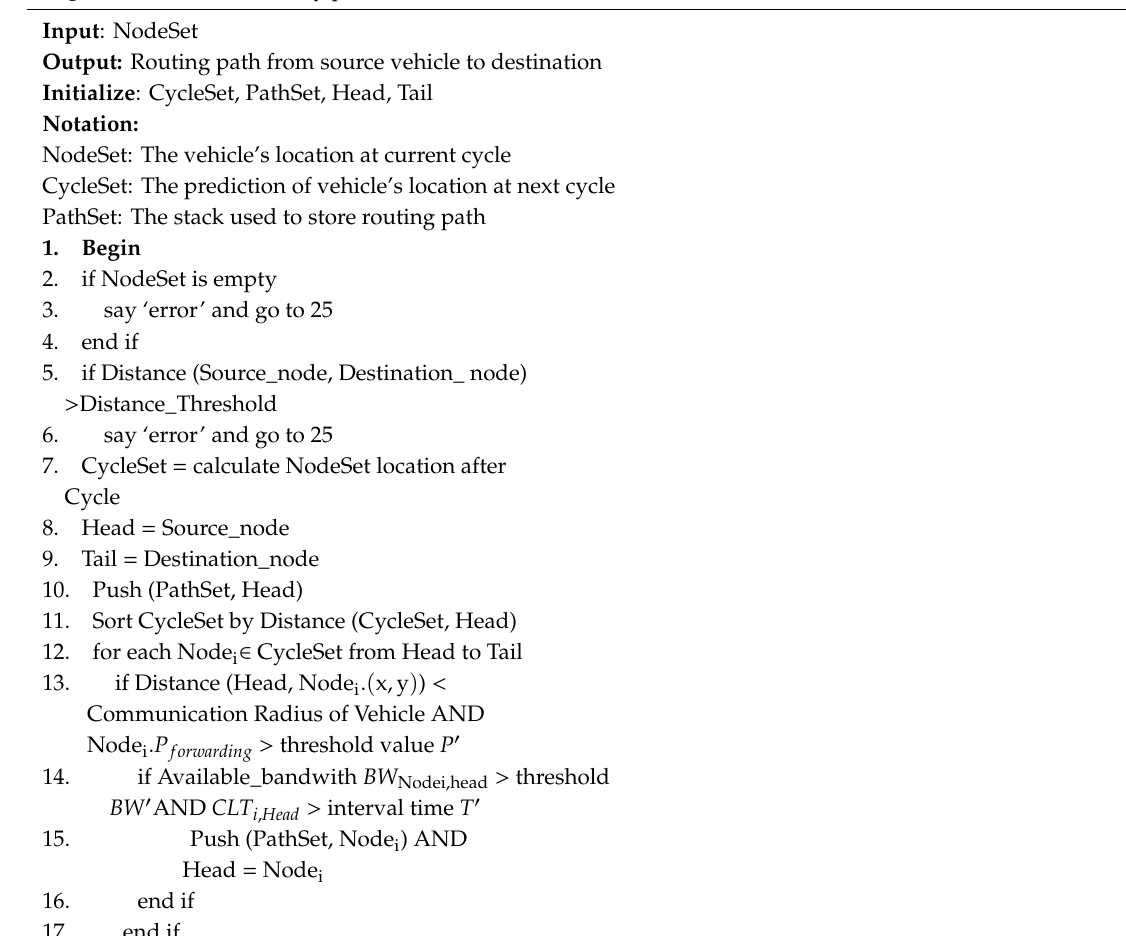
Algorithm 1 route discovery